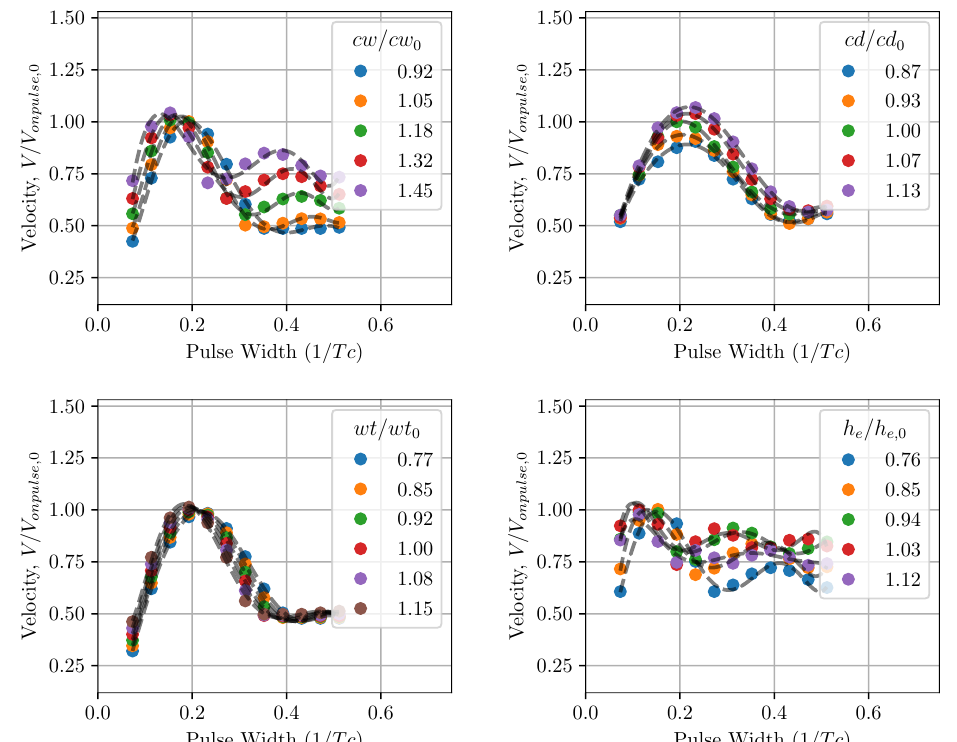
Figure 21. Pulse characteristics of droplet velocity in the inkjet head with changes in the channel’s geometrical parameters. Note the effect of the dimensions of the inkjet channel on on-pulse condition.